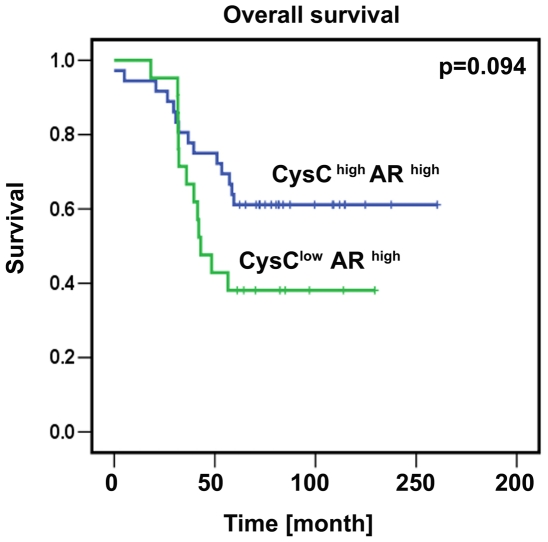
Kaplan-Meier survival analysis in 99 patients with advanced prostate cancer.Overall survival in a group of 99 patients with the most advanced prostate cancer (Gleason grade 4–5) which were characterized by high expression of AR and were separated to different groups based on cystatin C levels (low- intensity score 0–1.5 and high- intensity score 2–3).